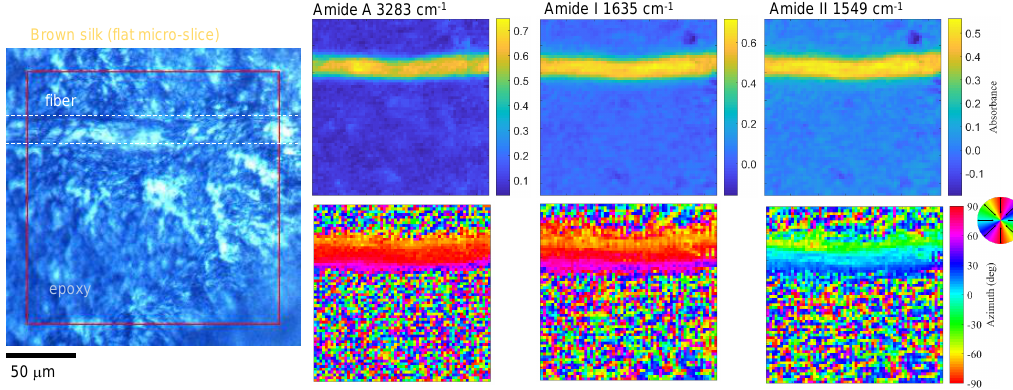
Figure 6. Optical image of a micro-thin brown silk microtome slice and its absorbance and azimuth maps at single wavelengths of specific bands acquired using a thermal IR source; the baselines were integrated from 3700 to 3710 cm − 1 and from 2000 to 2050 cm − 1 , for the Amide A and Amide I and II bands,